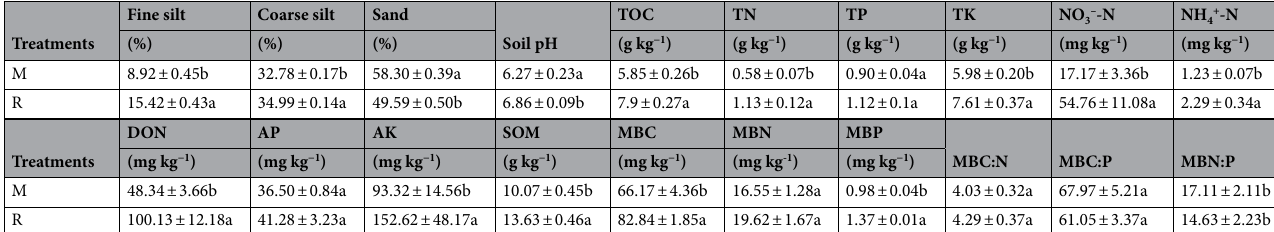
Table 1. The soil physical–chemical and biological properties. Mean ± standard deviation. Values within the same column followed by the same subscripted lower-case letters do not differ at p < 0.05. TOC total organic carbon, TN total nitrogen, TP total phosphorus, TK total potassium, NO 3– -N nitrate nitrogen, NH 4+ -N ammonium nitrogen, DON dissolved organic nitrogen, AP available phosphorus, AK available potassium, SOM soil organic matter, MBC microbial biomass carbon, MBN microbial biomass nitrogen, MBP microbial biomass phosphorus, M tobacco monoculture, R tobacco-rice